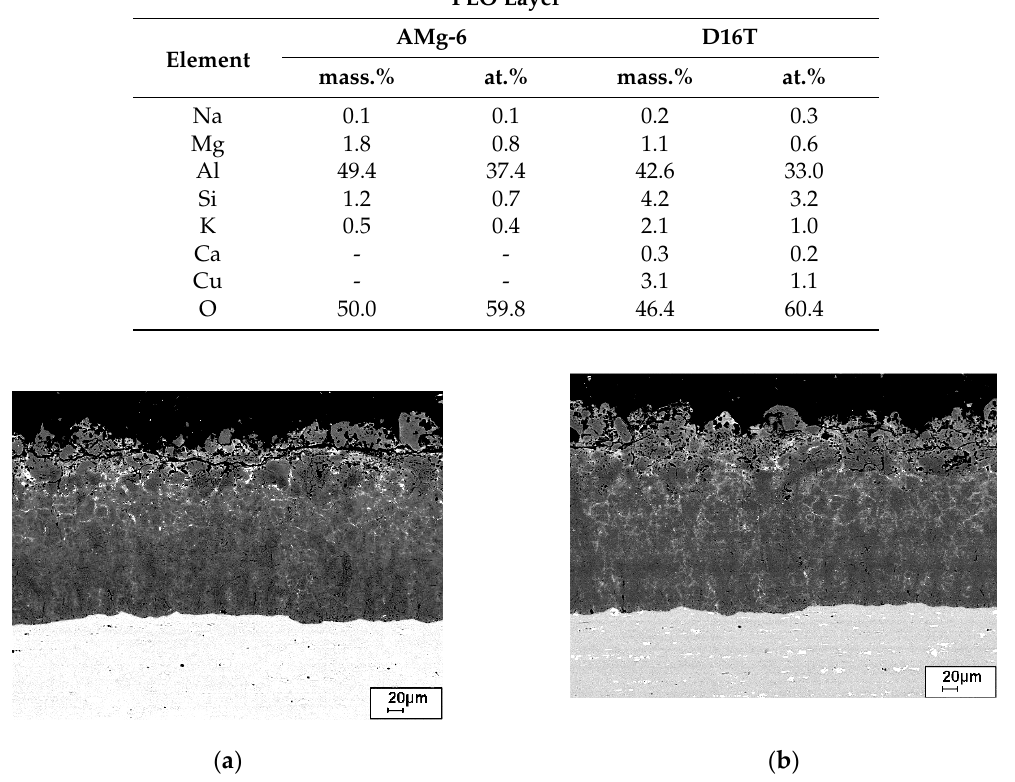
Figure 3. Microstructure of PEO layers synthesized on the alloys AMg-6 ( a ), D 16T ( b ).